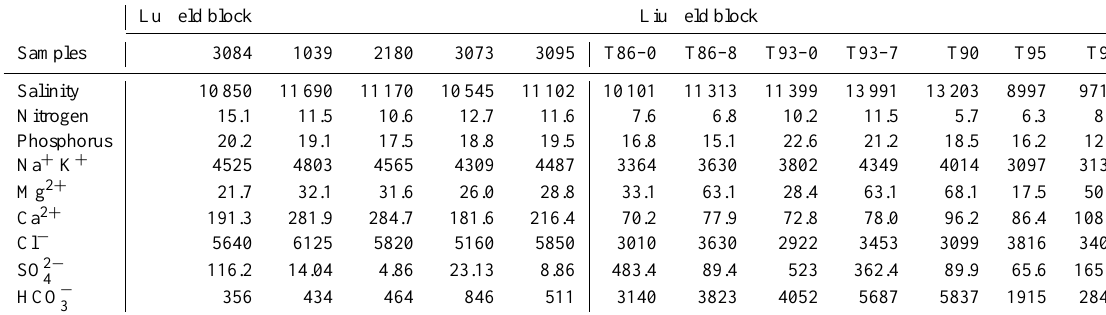
Table 2. Chemical properties of the water samples obtained from the Lu and Liu field blocks (Unit: mgL − 1